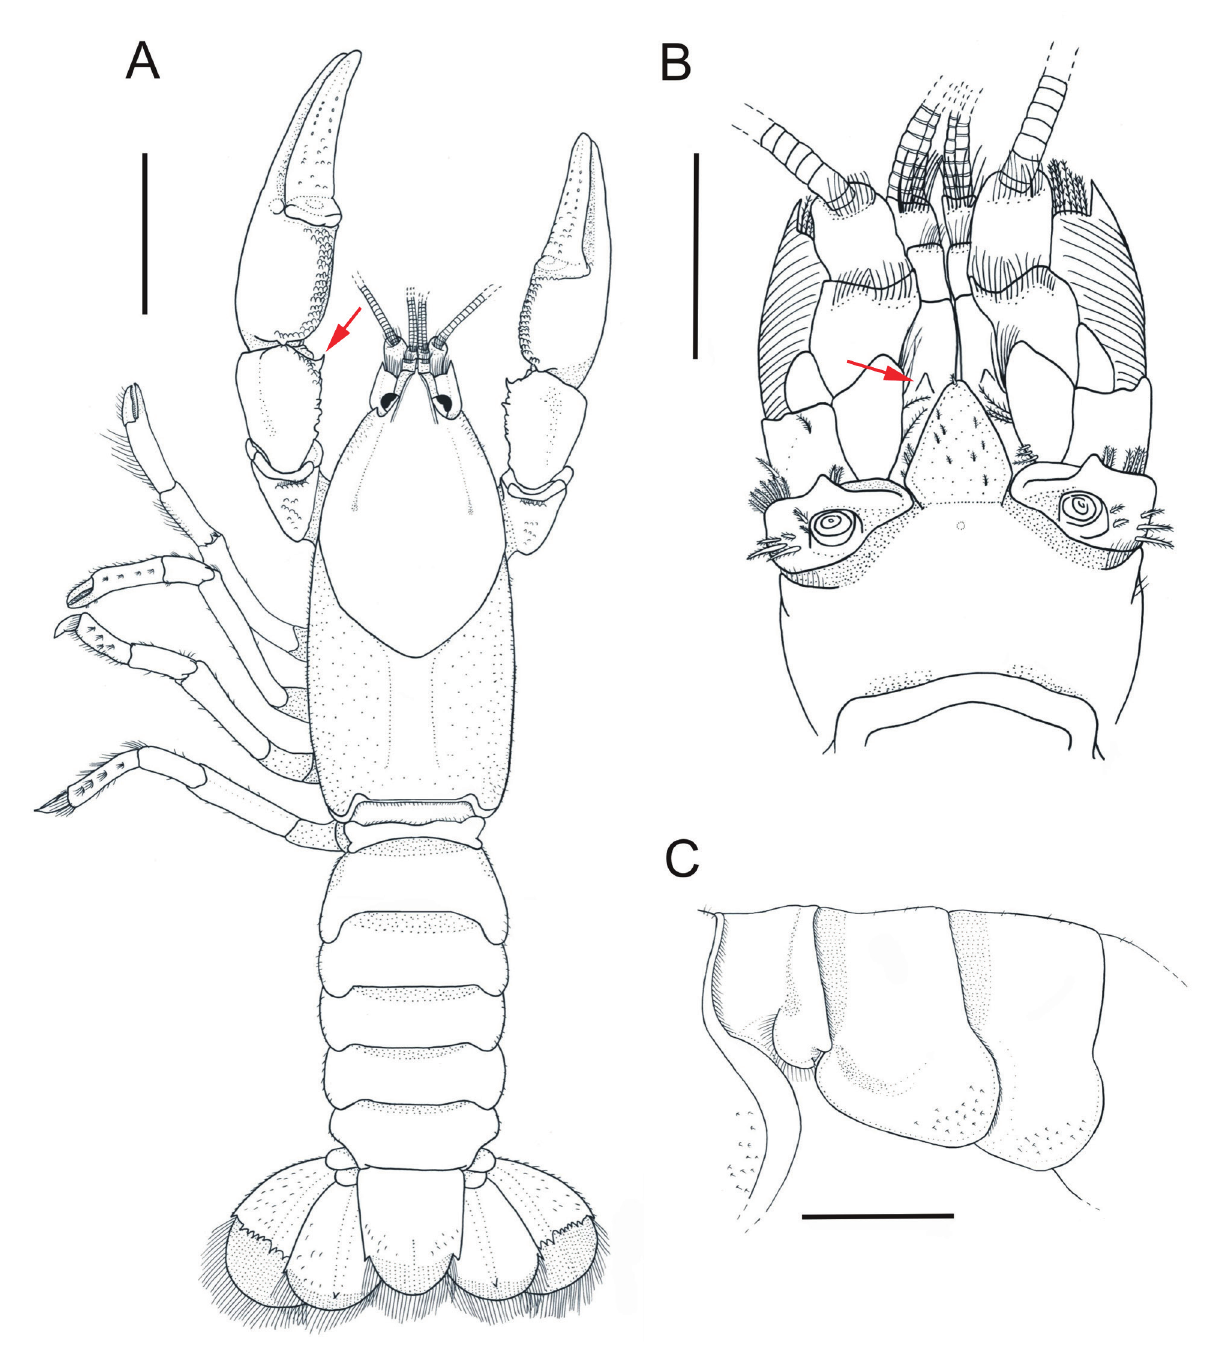
Figure 3. Parastacus tuerkayi sp. nov., female paratype (UFRGS 6376). A, habitus, dorsal view; B, epistome; C, first and second abdominal pleura. Scale bars: A = 1 cm; B, C = 5 mm. Red arrows indicate the spine on the carpus and on the internal ventral border of basal article of antenulle respectively in A and